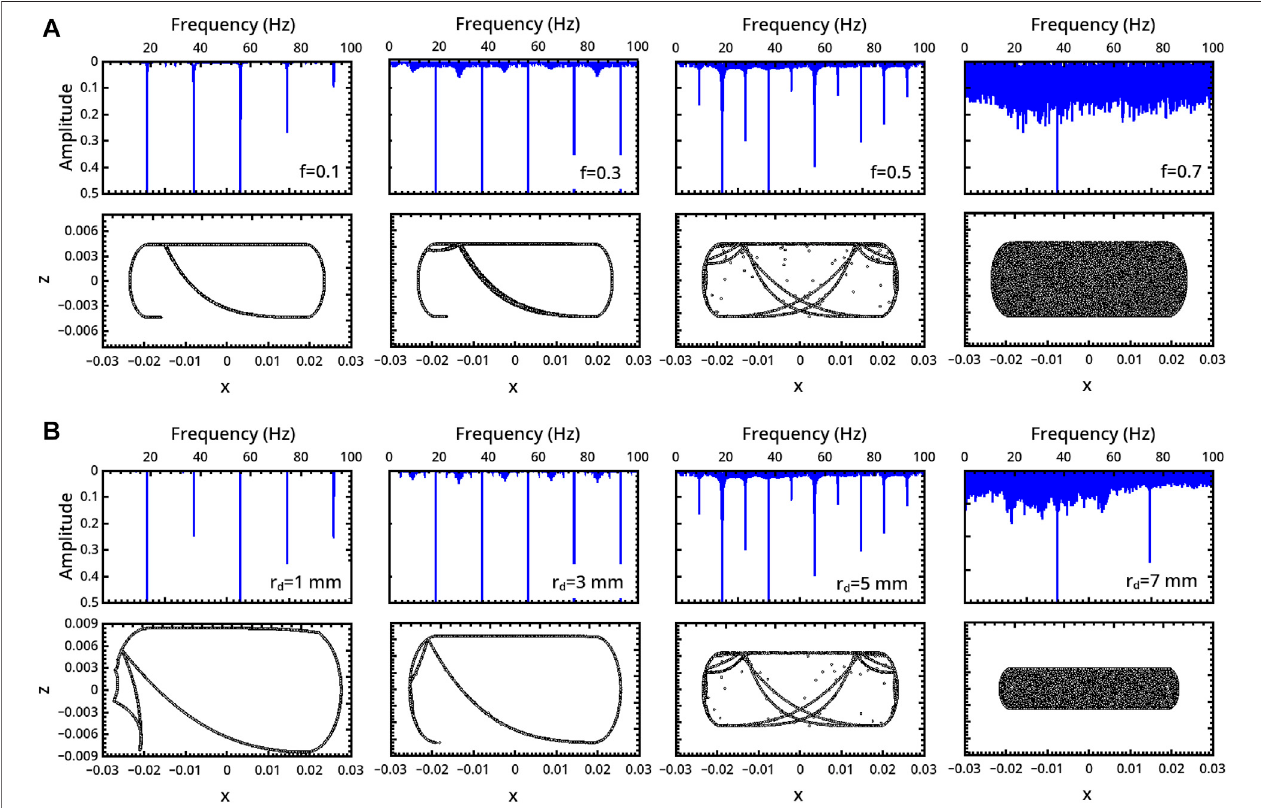
FIGURE 4 | Characterization of the milling body dynamics in a curved-base geometry as a function of (A) the restitution coef fi cient f ( r d = 5 mm) and (B) the milling disc radius r d ( f = 0.5). For each regime, we report the trajectory (bottom) and the FFT of the time series describing the vertical displacement of the milling disc